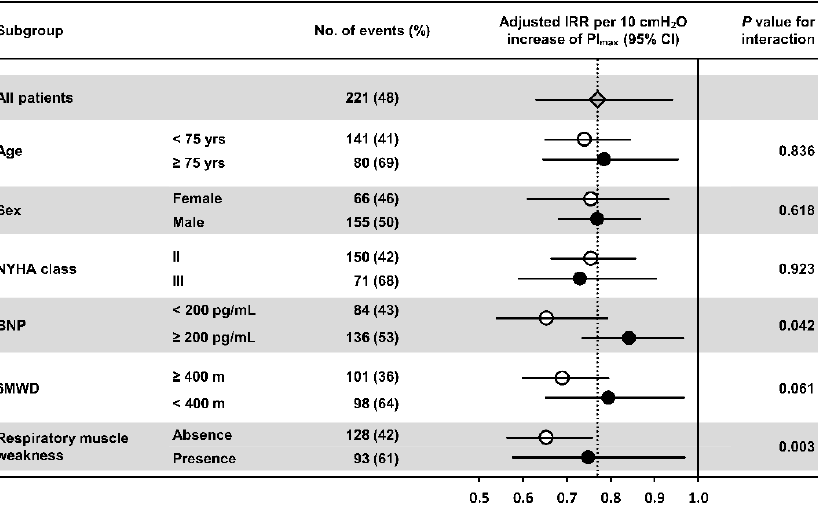
Figure 3. Forest plots of hazard ratios for the association of change in respiratory muscle strength with all-cause clinical events according to major subgroups. Hazard ratios were adjusted for age, sex, BMI, AHEAD score, NYHA class, and BNP at the end of the 5-month cardiac rehabilitation. BMI, body mass index; BNP, brain natriuretic peptide; IRR, incident rate ratio; NYHA, New York Heart Association functional classification; PI max , maximal inspiratory pressure; 6MWD, 6-min walk distance.